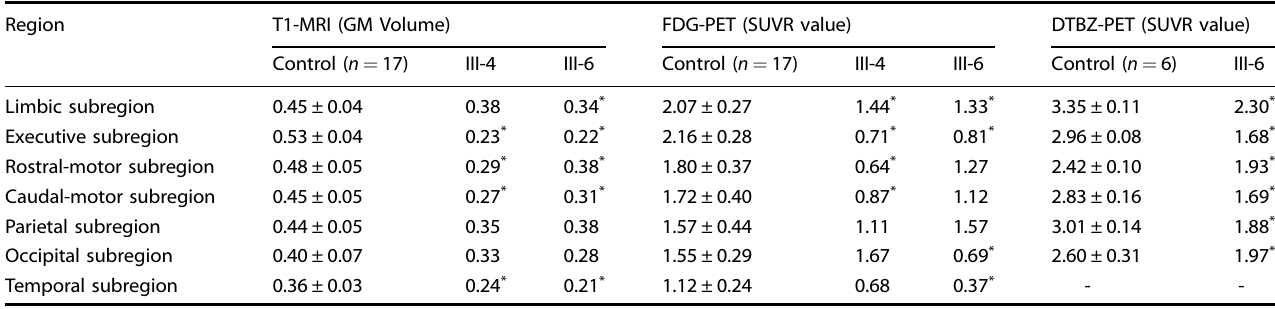
Table 1. Results of the striatal functional distribution in FTDP patients with the C9orf72 Repeat Expansions by T1-MRI, FDG-PET/MRI and DTBZ-PET/CT.